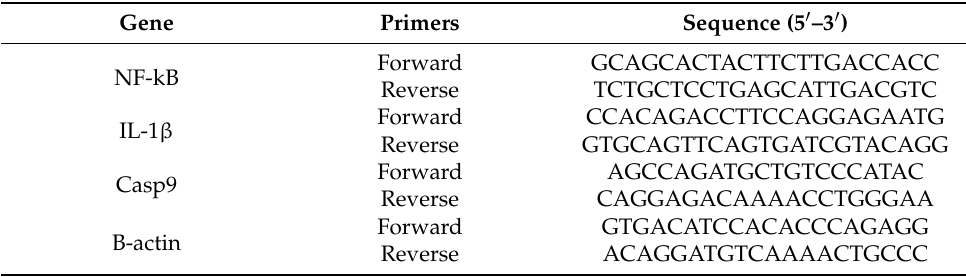
Table 1. Genes and primer sequences used for the real-time PCR. Gene Primers Sequence (5 (cid:48) –3 (cid:48)